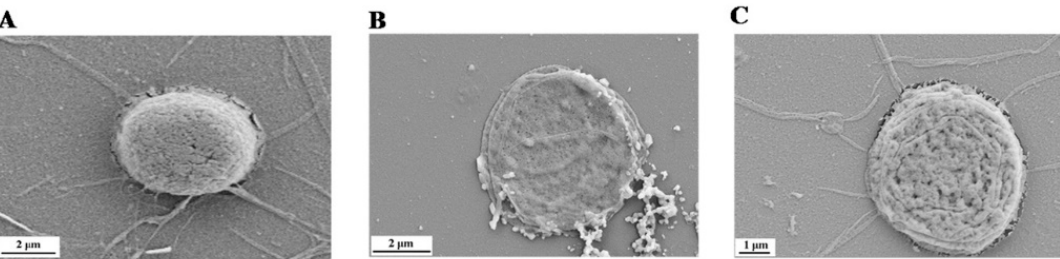
Figure 3. Protective effects of kaempferol on the images of human erythrocytes by scanning electron microscopy. ( A ) Normal human erythrocytes. ( B ) Damaged erythrocytes by 100 mM AAPH alone for 2 h. ( C ) Pretreated erythrocytes with 80 µ M kaempferol before erythrocytes were cultured with 100 mM AAPH for 2 h.